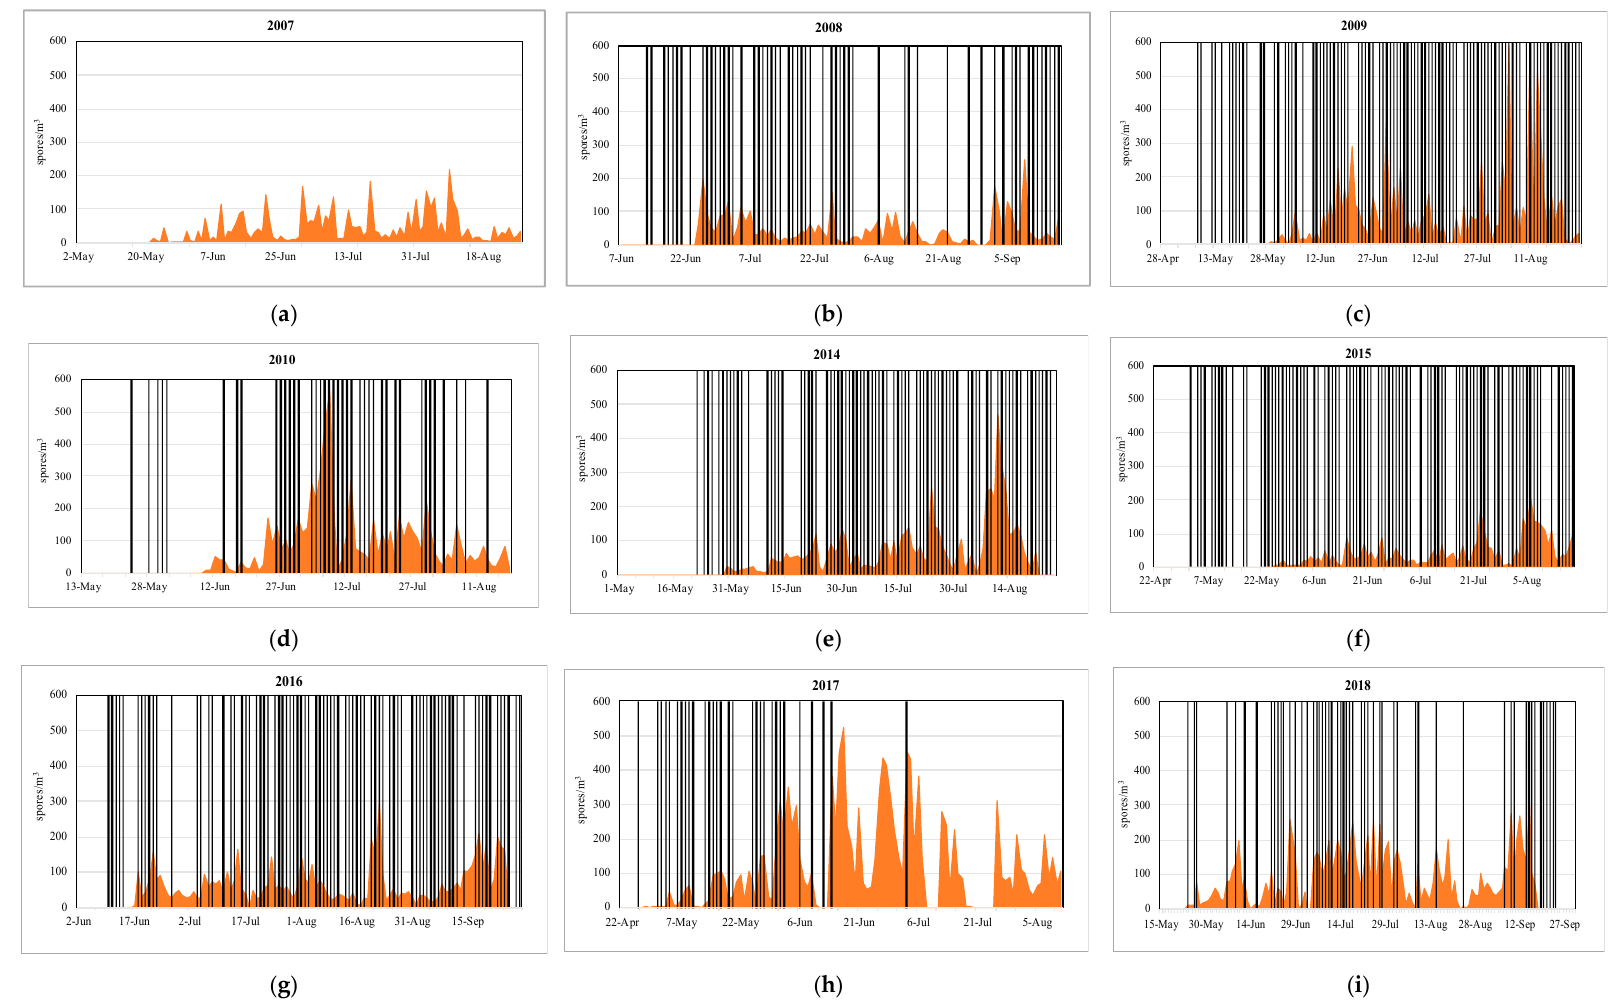
Figure 4. Days with interrupted wet periods (bars) by crop cycle. Each subfigure ( a – i ) includes the results of interrupted wet periods by crop cycle studied.